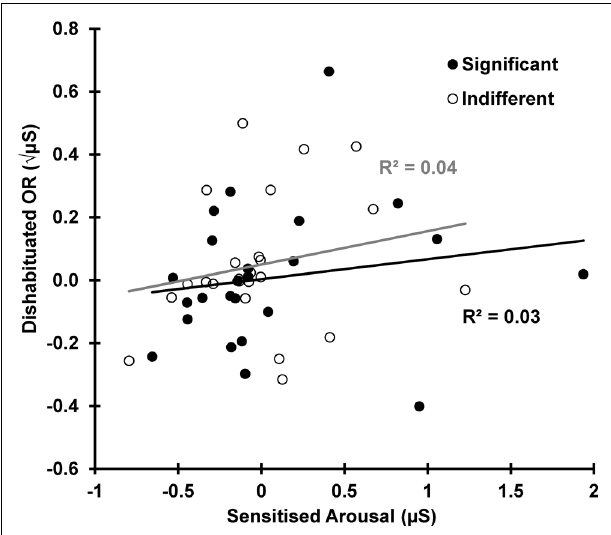
FIGURE 7 | Dishabituation as a function of sensitization for both conditions. OR dishabituation is not due to the deviant-related sensitization.